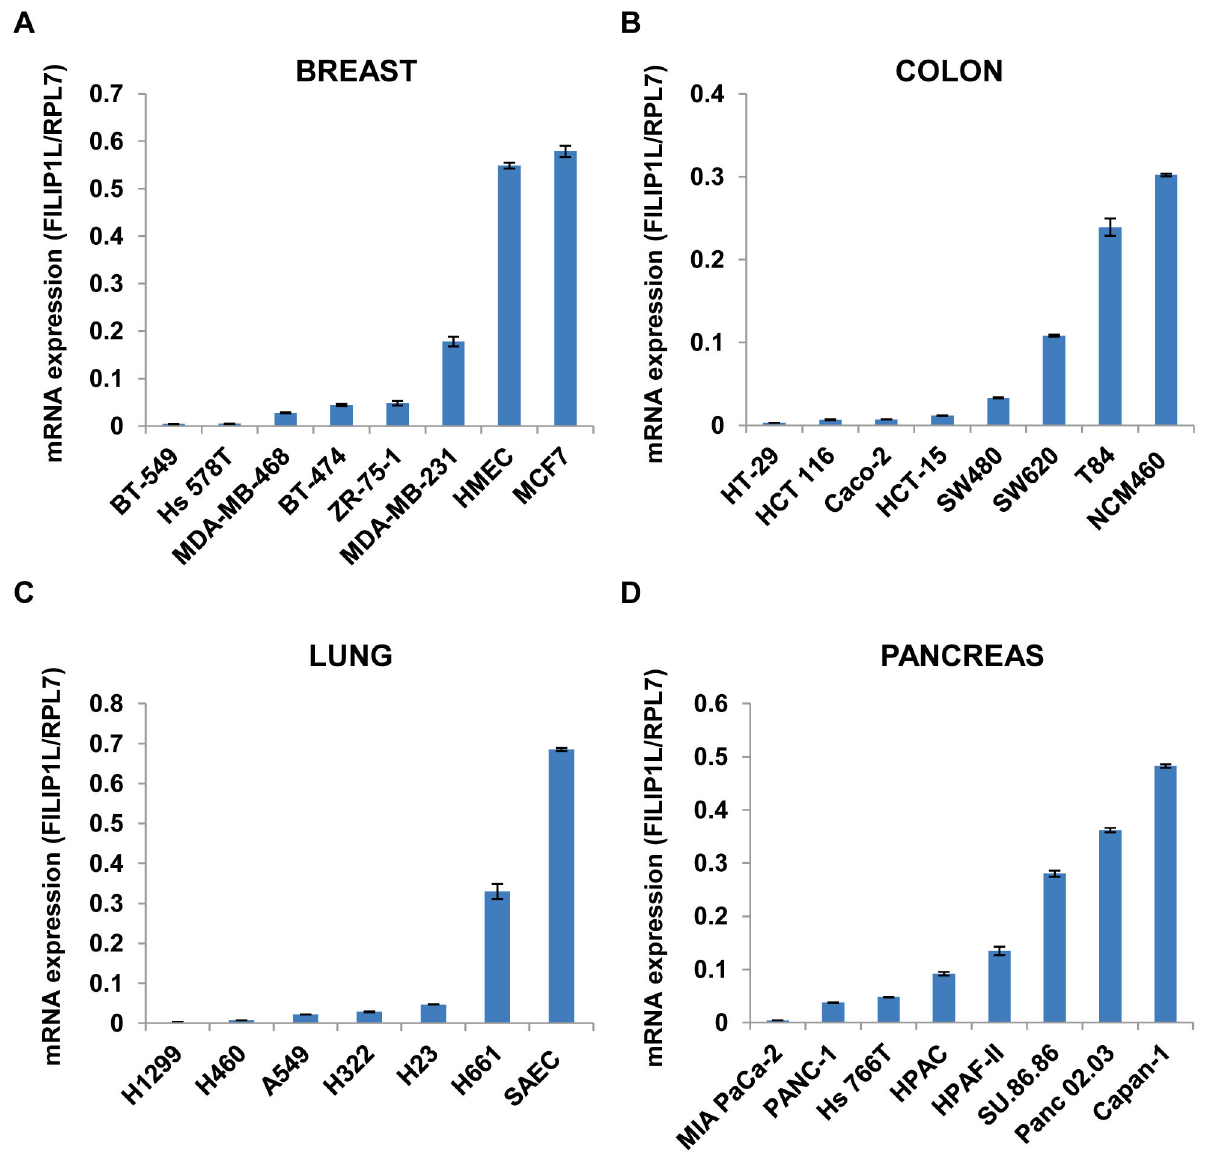
Figure 1. Differential expression of FILIP1L mRNA in various human cancer cell lines. qRT-PCR analysis for FILIP1L conducted on cDNA from human breast ( A ), colon ( B ), lung ( C ) and pancreatic ( D ) cancer cell lines. The y axis represents FILIP1L mRNA expression which was standardized with the housekeeping gene hRPL7 . Error bars indicate SEM ( n = 3). The result is an average of three independent